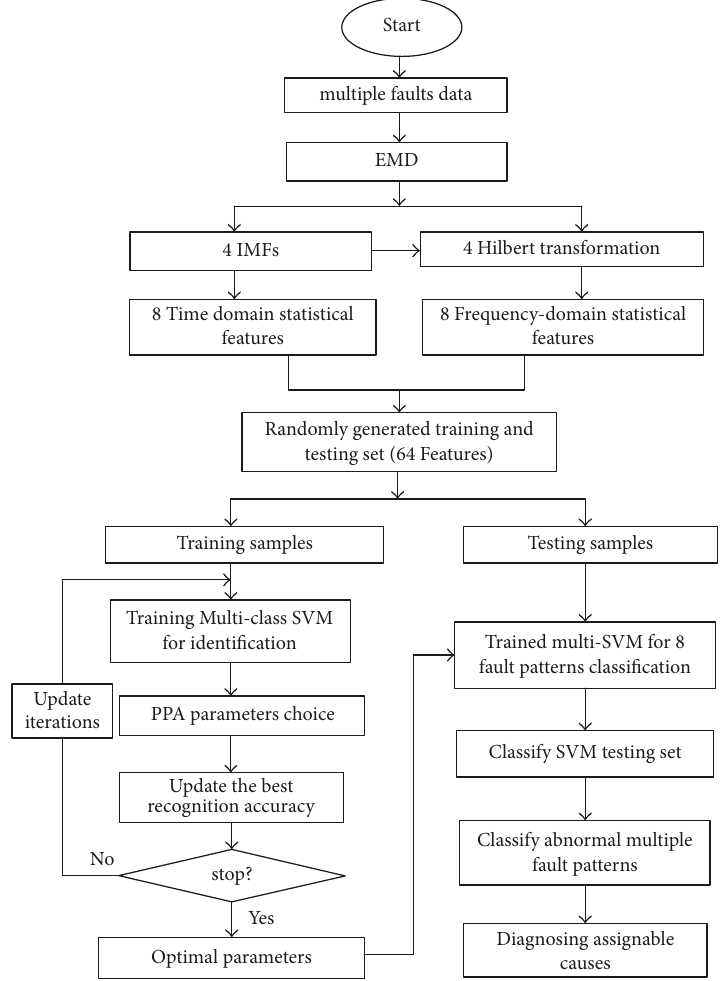
Figure 1: EMD MSVM PPA classification